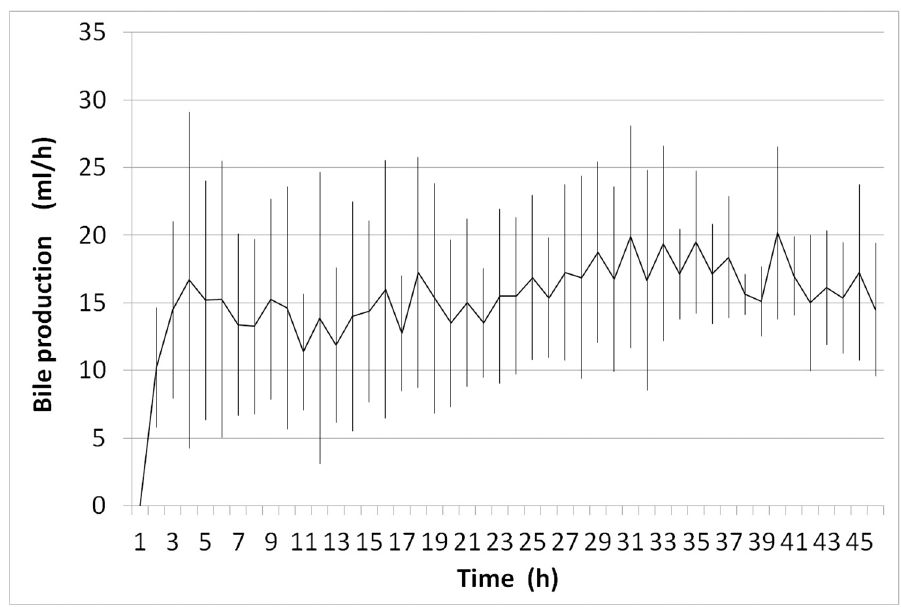
Fig 5. Mean bile secretionduring normothermic organ preservation. During normothermic perfusion all livers producedclear, viscous bile. Secretion started within two hours of perfusionand was sustaineduntil the end of the preservationperiod. (n = 4).